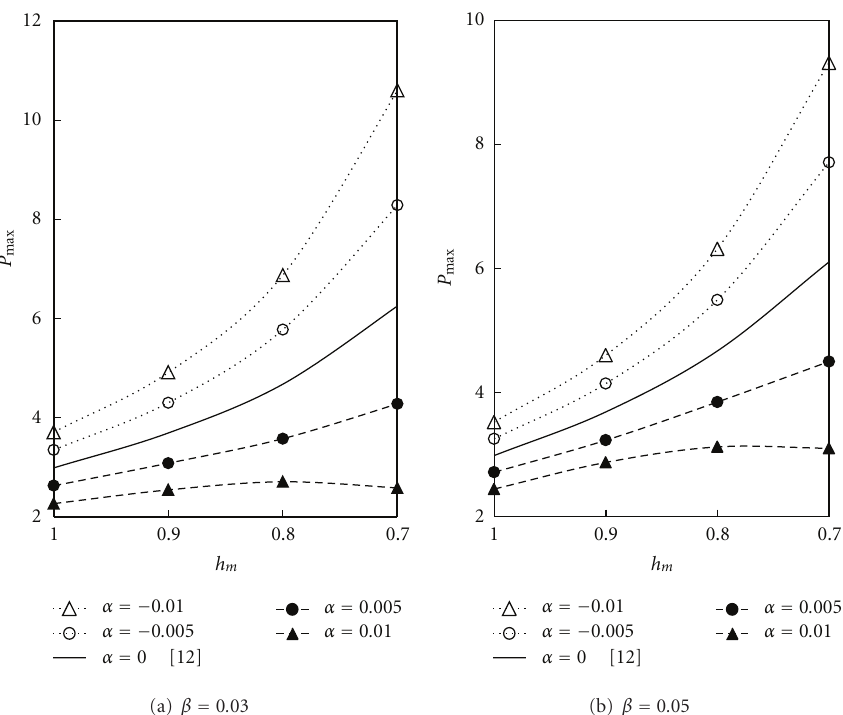
Figure 3: Variation of the dimensionless maximum film pressure with respect to the minimum film thickness h m for di ff erent values of parameter α .